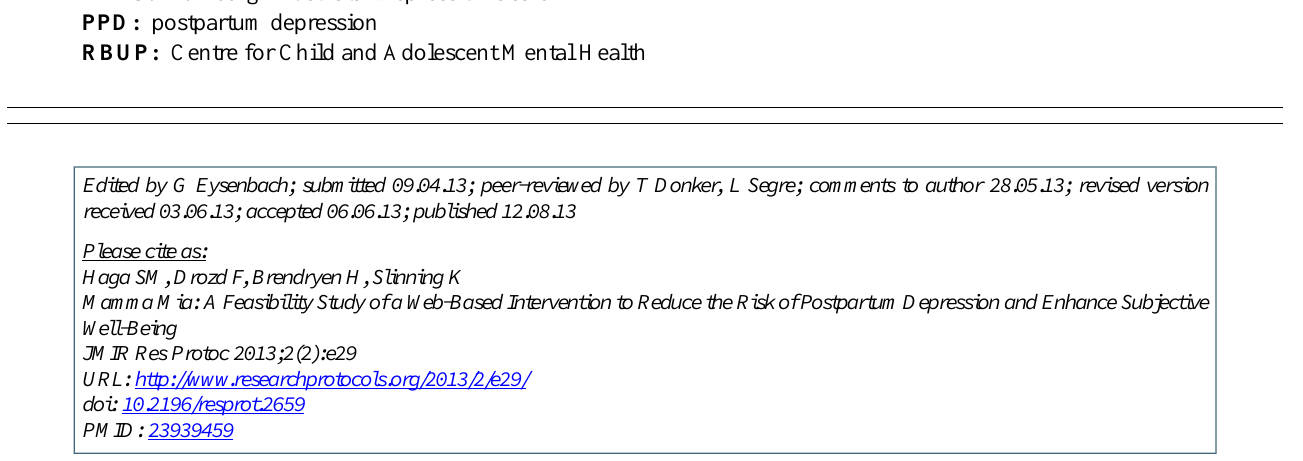
EPDS: Edinburgh Postnatal Depression Scale PPD: postpartum depression RBUP: Centre for Child and Adolescent Mental